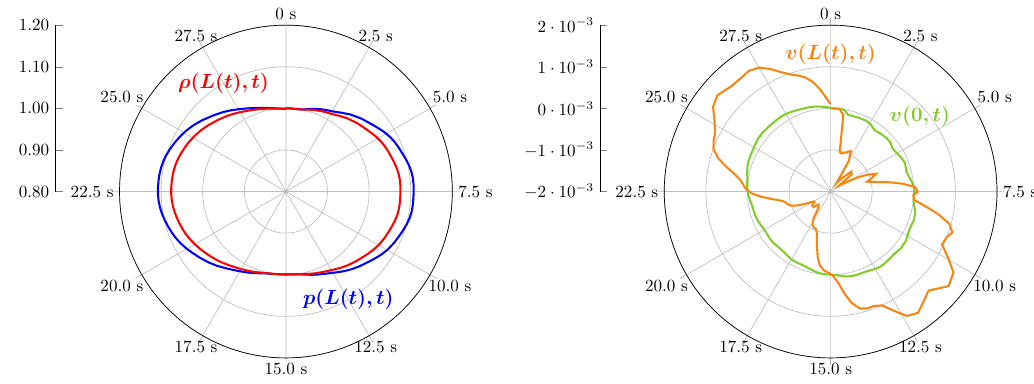
Figure 8. Time evolution of fluid density, pressure and velocity in polar